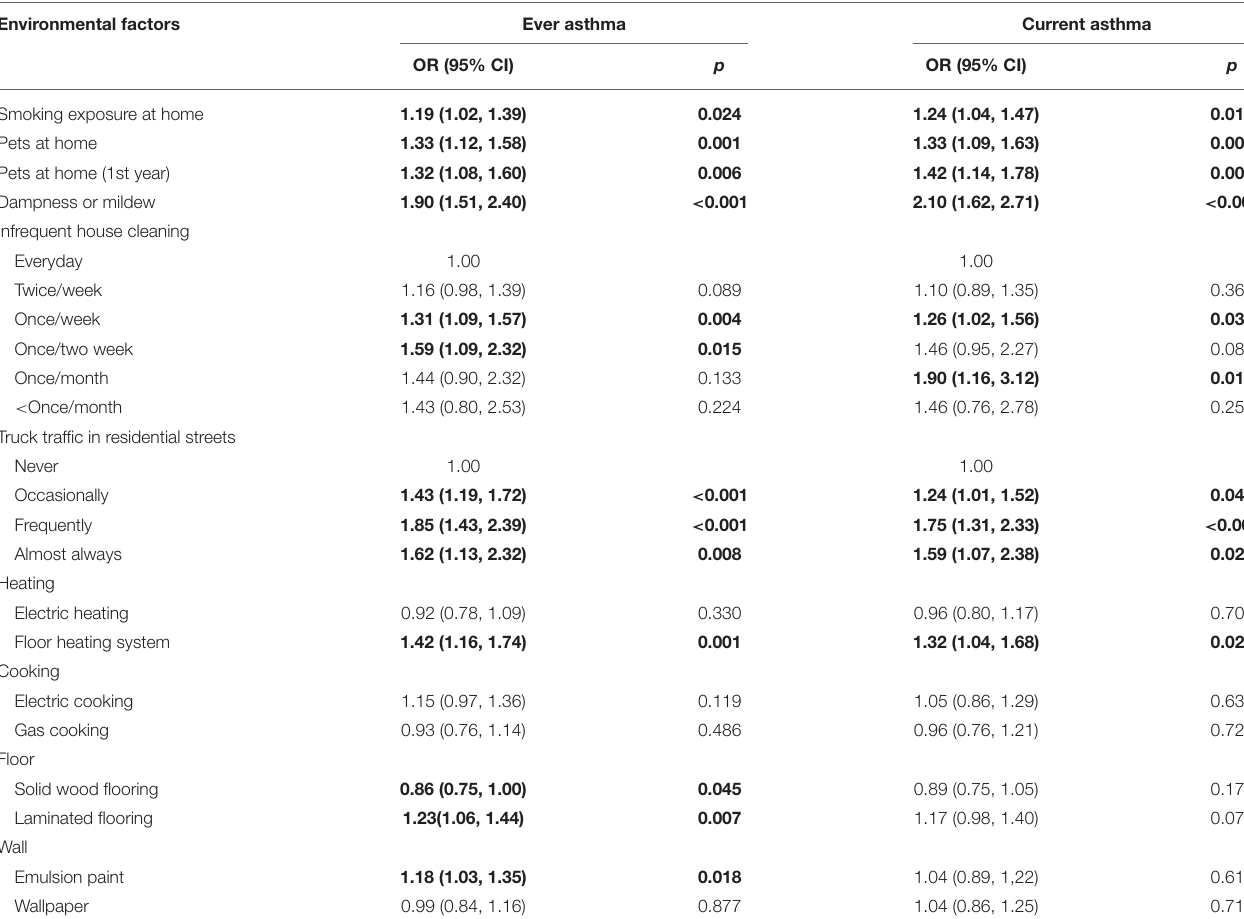
TABLE 3 | Environmental factors for asthma symptoms by univariate